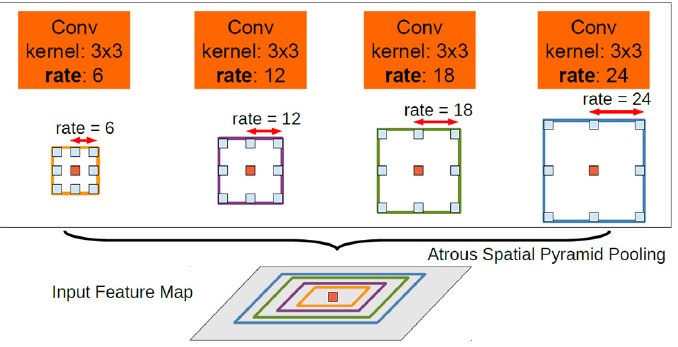
Figure 2. ASPP network structure [29].